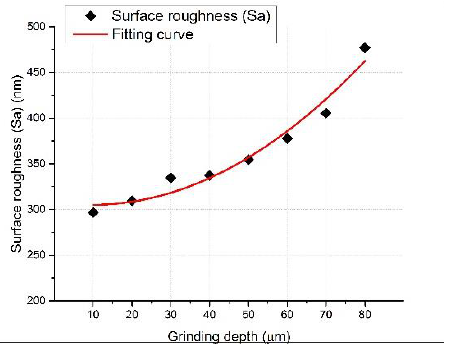
Figure 5. Influence of grinding depth on surface roughness.